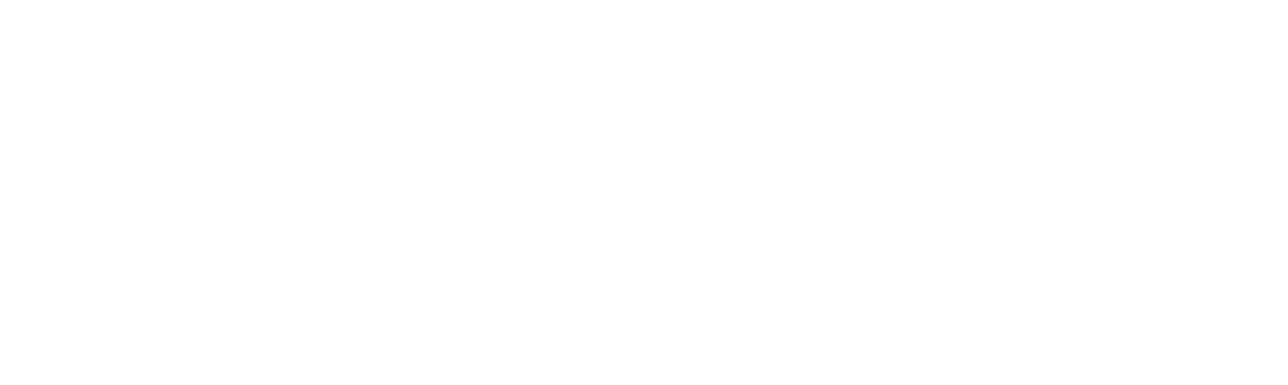
FIGURE Essentially, the co-culture system involves gently digesting adult (3- to 5-week-old) H-2b thymi with enzymes then enriching for stromal cells by zonal unit-gravity elutriation. These freshly prepared stromal cells were then co-cultured in hanging drops with El7 T- cell precursors from P14 TCR transgenic mice specific for the lymphocytic choriomeningitis virus (on a nonselecting background), over a period of 4 to 5 days in the absence or presence of nominal LCMV